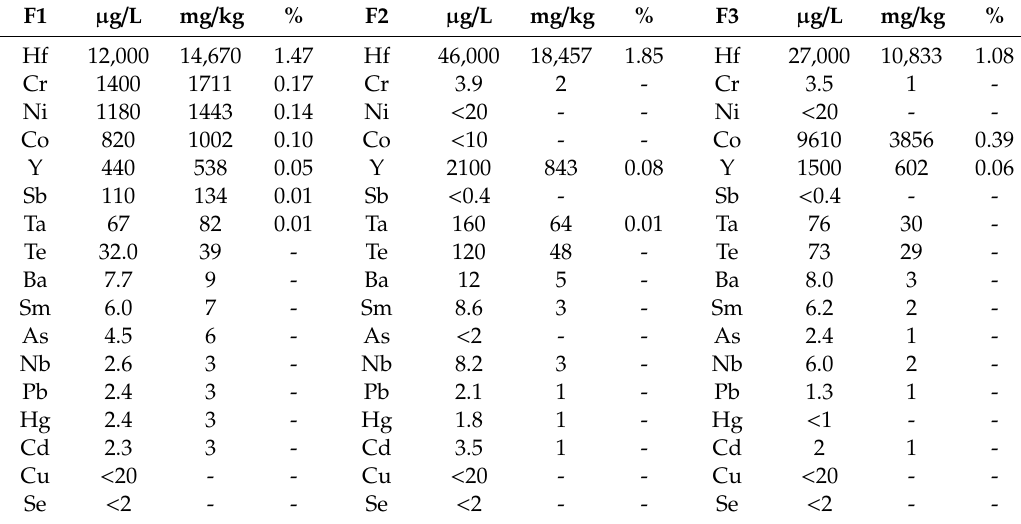
Table 14. ICP-OES and ICP-MS analysis results and conversion to units [mg / kg] and [%].